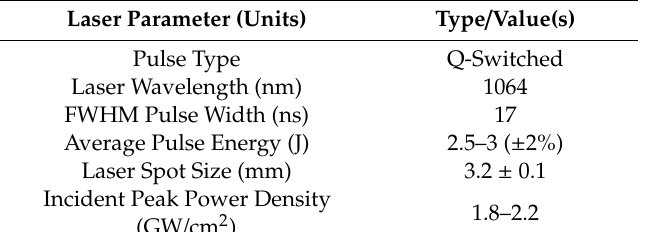
Metals 2019 , 9 , x FOR PEER REVIEW 7 of 26 Table 1. Laser parameters [37,38], with permission from ASME, 2019.